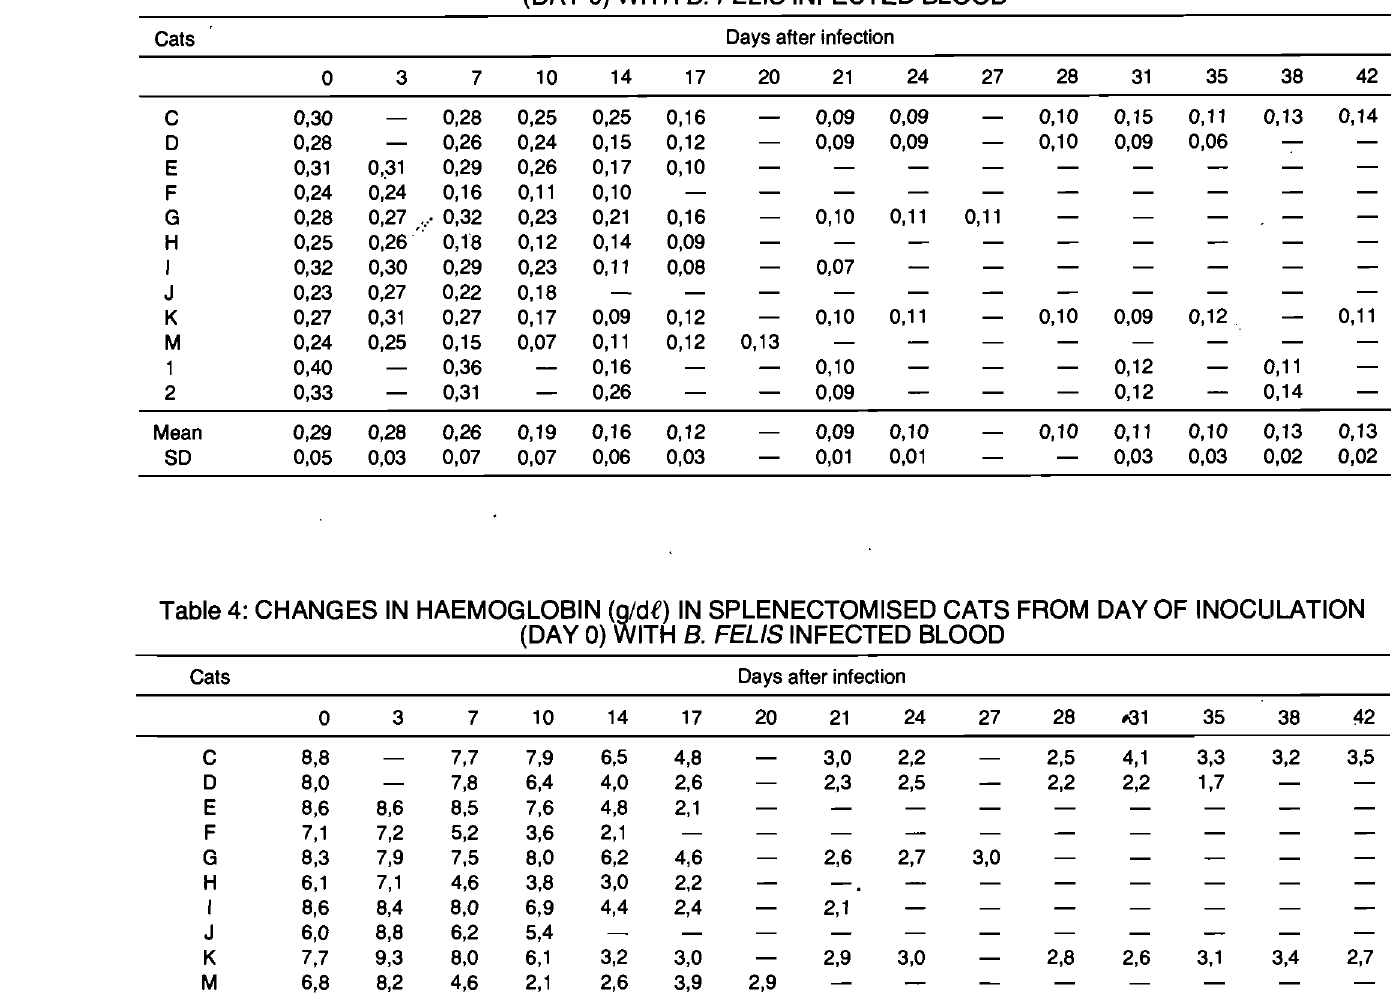
Table 6: THE CHANGES IN BLOOD ERYTHROCYTE COUNT (x 1012Je) IN SPLENECTOMISED CATS FROM DAY OF INOCULATION (DAY 0) WITH B. FELIS INFECTED